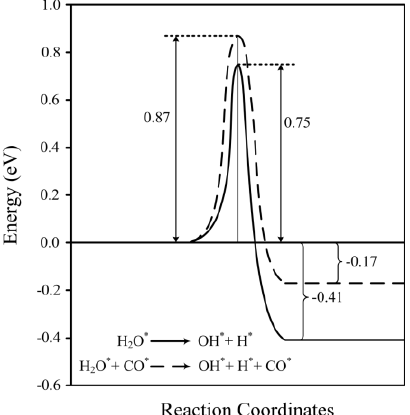
Figure 4. Reaction profiles for the water dissociation with ( dashed line ) and without ( solid line ) co-adsorbed